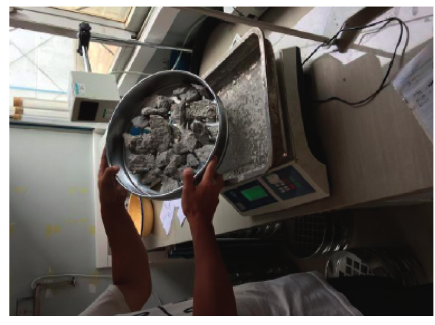
Figure 12: Fragments weighing. Table 7: Statistical table of blasting block degree of wedge-shaped notch model